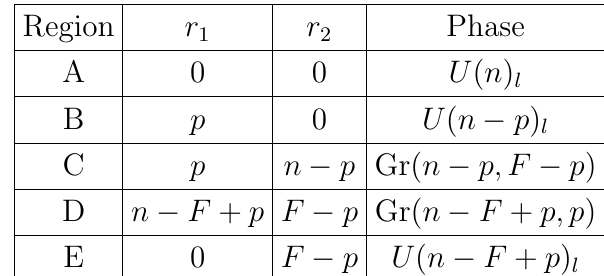
F p F n . The region ≤ − ≤ ≤